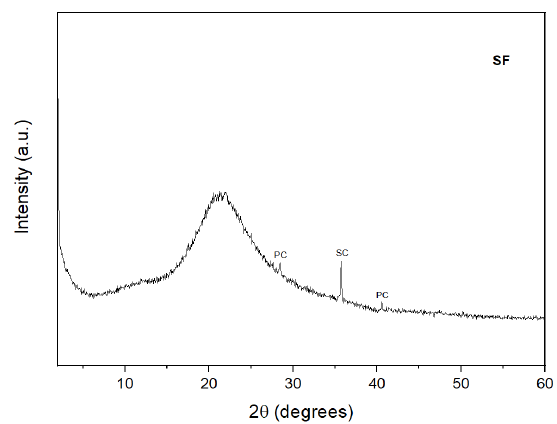
Figure 5. X-ray diffractogram of the silica fume. PC-potassium chloride, SC-silicon